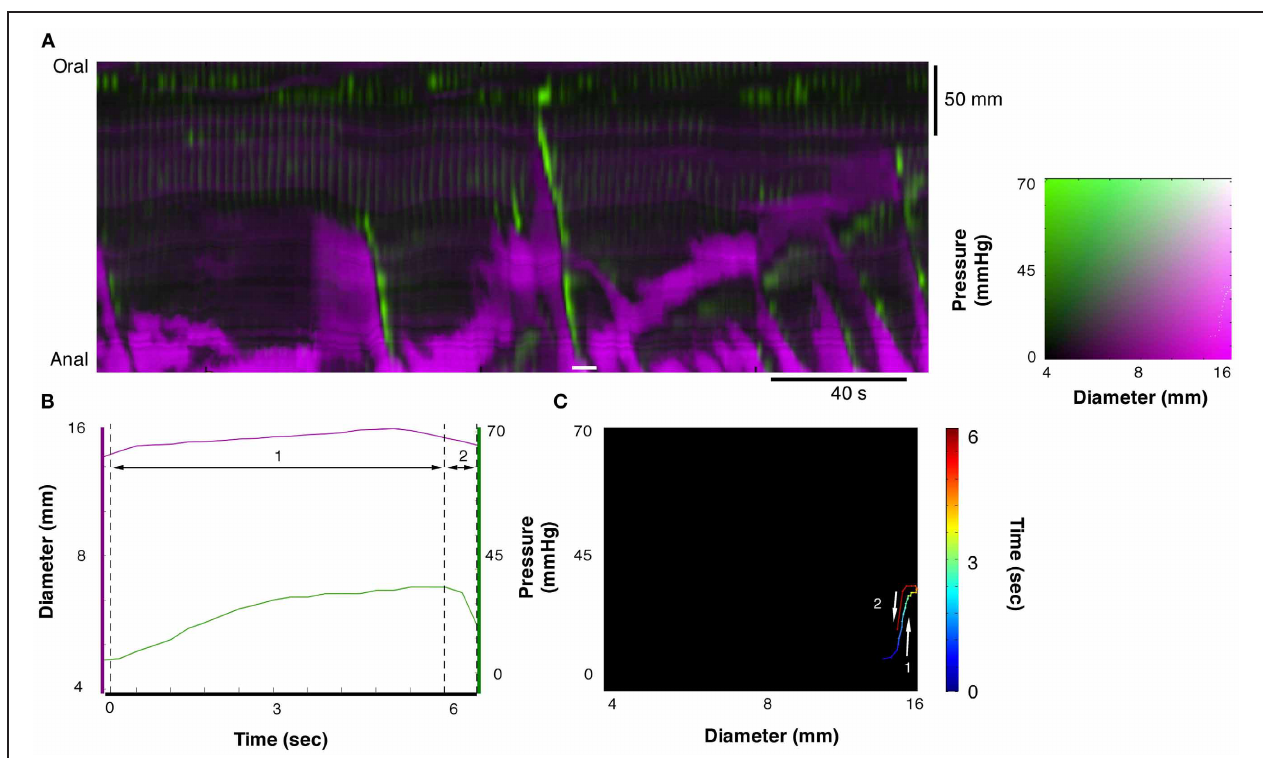
increasing pressure with little change in diameter ( passive isometric pressure increase ). Segment 2 of the plot shows the reduction in pressure with little change in diameter ( passive isometric pressure decrease ). These two states are described in Figure 3E